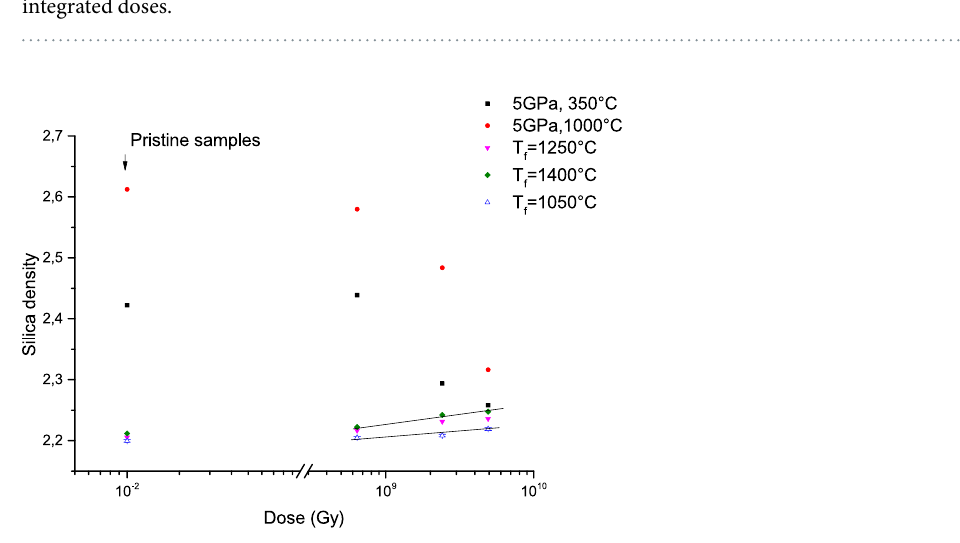
Figure 1. Evolution of the silica density for different pre-densified samples with the integrated dose